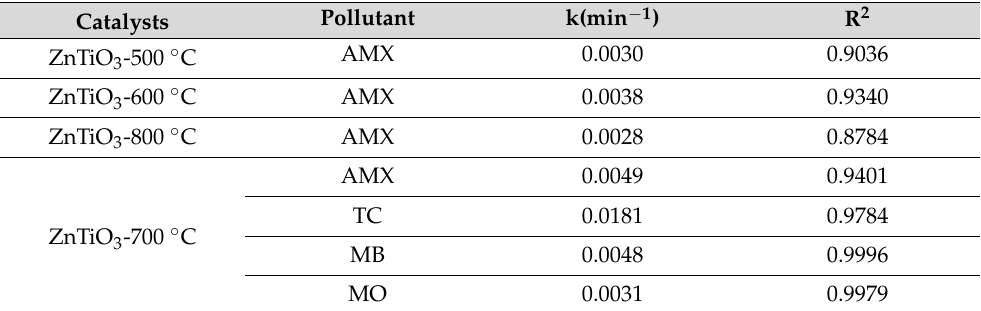
Figure 10. The photocatalytic performance based on the first-order kinetics model ( a ) in degrading AMX on various ZnTiO 3 calcinated at 500–800 ◦ C and ( b ) in degrading TC, MB, MO, and AMX using ZnTiO 3 -700 ◦ C. Table 3. First-order rate constants of various ZnTiO 3 for the photocatalytic degradation of various